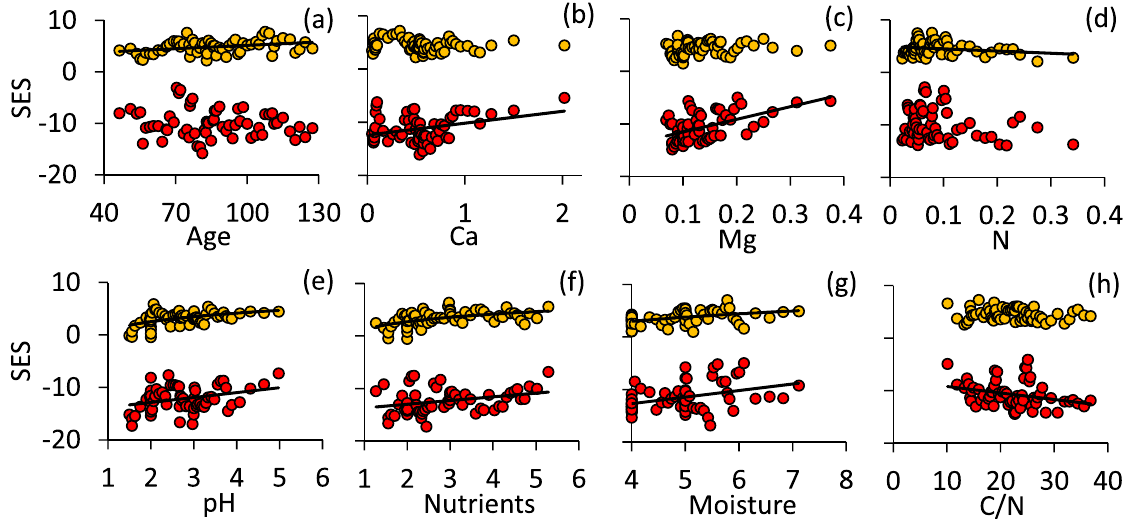
Figure 4. Dependences of standardized effects sizes (SES based on the equiprobable-equiprobable null model) of the C-score (red dots) and NODF (yellow dots) on plot average tree age ( a ), total Ca ( b ), Mg ( c ), and N ( d ) content, Ellenberg value based indices for light ( e ), nutrient ( f ), and moisture demands ( g ), and soil C/N ratios ( h ). Linear OLS regressions of the C-score in ( b ) r 2 = 0.11 (P(F) < 0.01, ( c ) r 2 = 0.30 (P(F) < 0.001, ( e ) r 2 = 0.11 (P(F) < 0.01, ( f ) r 2 = 0.10 (P(F) < 0.05, ( f ) r 2 = 0.13 (P(F) < 0.01, ( h ) r 2 = 0.11 (P(F) < 0.01. Logarithmic OLS regressions of NODF in ( a ) r 2 = 0.12 (P(F) < 0.01, ( d ) r 2 = 0.06 (P(F) < 0.10, ( e ) r 2 = 0.24 (P(F) < 0.001, ( f ) r 2 = 0.27 (P(F) < 0.001, ( g ) r 2 = 0.18 (P(F) < 0.01.